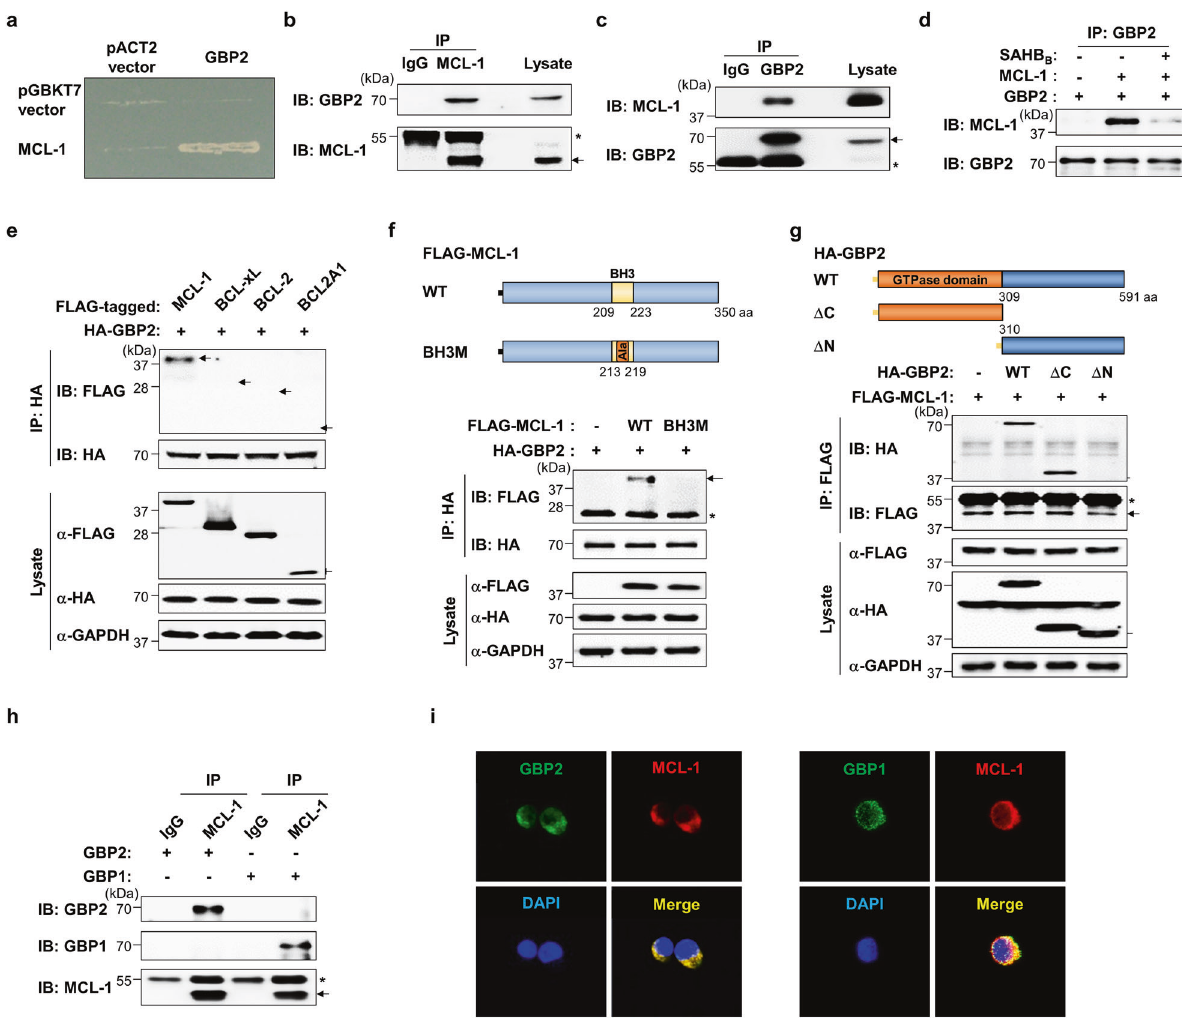
Fig. 1 GBP1 and GBP2 speci fi cally interact with MCL-1. a Yeast growth was demonstrated in colonies expressing both GBP2 and MCL-1 fused to the GAL4 DNA activation domain and binding domain, respectively. b , c The endogenous protein – protein interaction between GBP2 and MCL-1 was con fi rmed using immunoprecipitations followed by western blot analyses using indicated antibodies in K562 cells ( b ) and HL-60 cells ( c ). IgG was used as an immunoprecipitation control. d In vitro binding of GBP2 and MCL-1 was determined using puri fi ed recombinant proteins (0.5 µg) of GBP2 and MCL-1 with or without the presence SAHB B (10 µM), a BH3-speci fi c inhibitor of MCL-1. Subsequently, immunoprecipitation and immunoblotting were performed with indicated antibodies. e The interaction of GBP2 with prosurvival members of the BCL-2 family was examined by immunoprecipitation following cotransfection of 3 µg of plasmids encoding HA-GBP2 and FLAG-BCL-2 family members in K562 cells. Arrows indicate the expected positions of respective proteins. GAPDH was included as a loading control. f , g